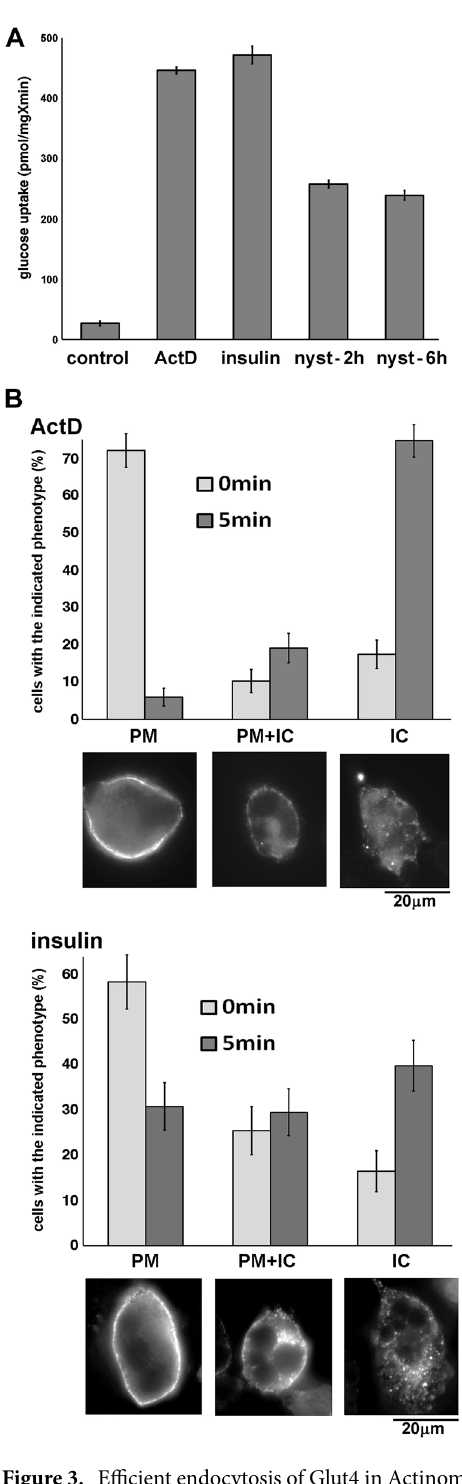
Figure 3. Efficient endocytosis of Glut4 in Actinomycin D-treated adipocytes. Panel ( A ): Glucose uptake in differentiated 3T3-L1 adipocytes treated or not treated with ActD (5 µM) for 18 h, insulin (100 nM) for 15 min, or nystatin (50 µg/ml) for 2 h and 6 h. The error bars represent standard deviations. Panel ( B ): Endocytosis of myc 7 -Glut4 in adipocytes treated with ActD (5 µM) for 18 h and insulin (100 nM) for 15 min was measured as described in Materials and Methods . Briefly, anti-myc monoclonal antibody was added for 1 h on ice to adipocytes stably expressing myc 7 -Glut4. Then, cells were either fixed with 4% formaldehyde (0 min), or transferred to pre-warmed DMEM for 5 min at 37 °C before fixation (5 min). Fixed cells were stained with Alexa Fluor 594-conjugated anti-mouse secondary antibody. PM—the antibody is almost exclusively associated with plasma membrane; IC—intracellular localization of the antibody, no detectable association with the plasma membrane; PM + IC—mixed phenotype. The error bars represent standard deviations. Representative images of cells with attributed phenotypes are shown at the